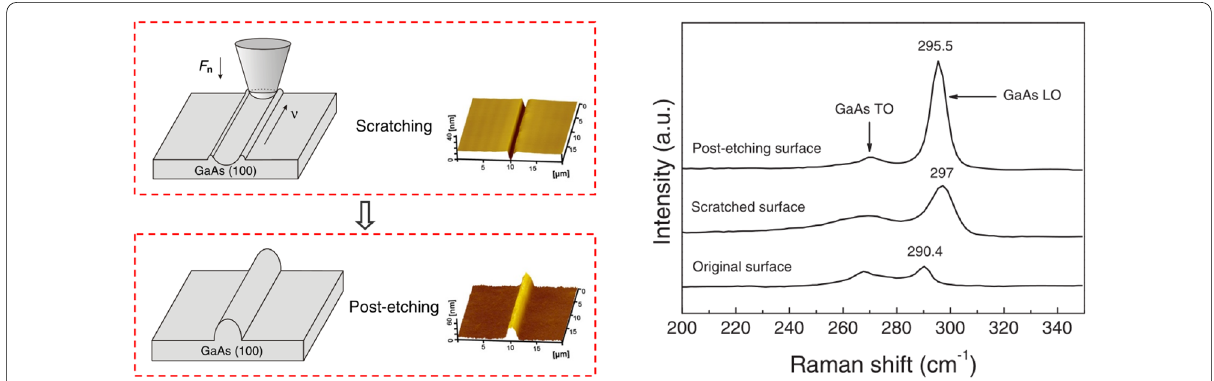
Figure 22 Friction-induced selective etching on GaAs surface [82]: ( a ) Schematic diagram and AFM images showing the fabrication process, ( b ) Raman detection on original GaAs surface, scratched surface, and post-etching surface (scratched surface after etching)